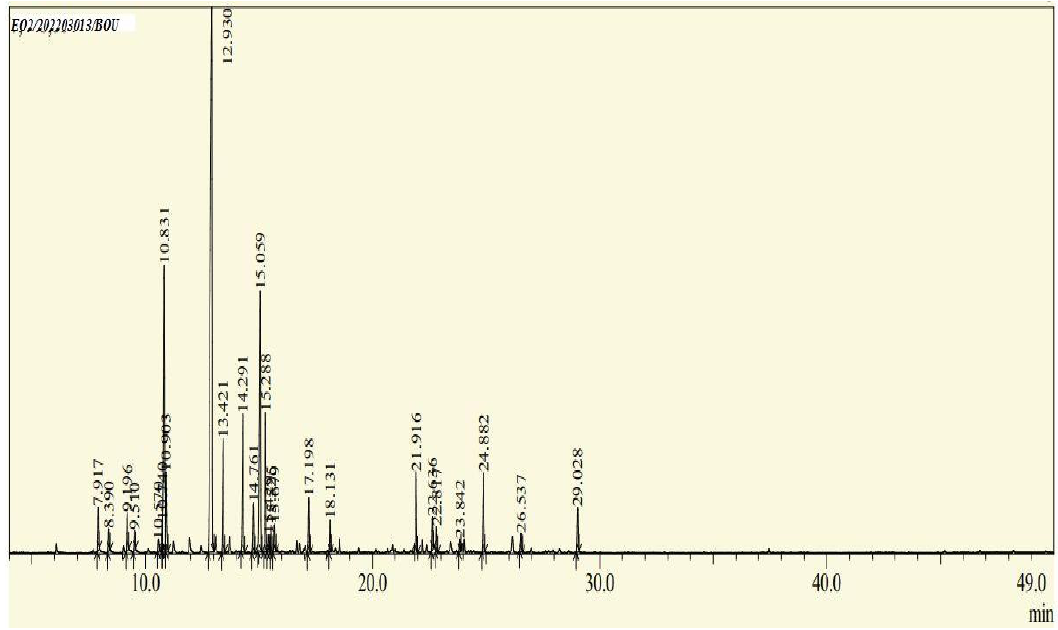
Figure 1. Chemical profile of identified compounds in EOBD by use of GC-MS. Table 1. Phytochemical compounds identified in EOBD by GC/MS. Retention Index Compound